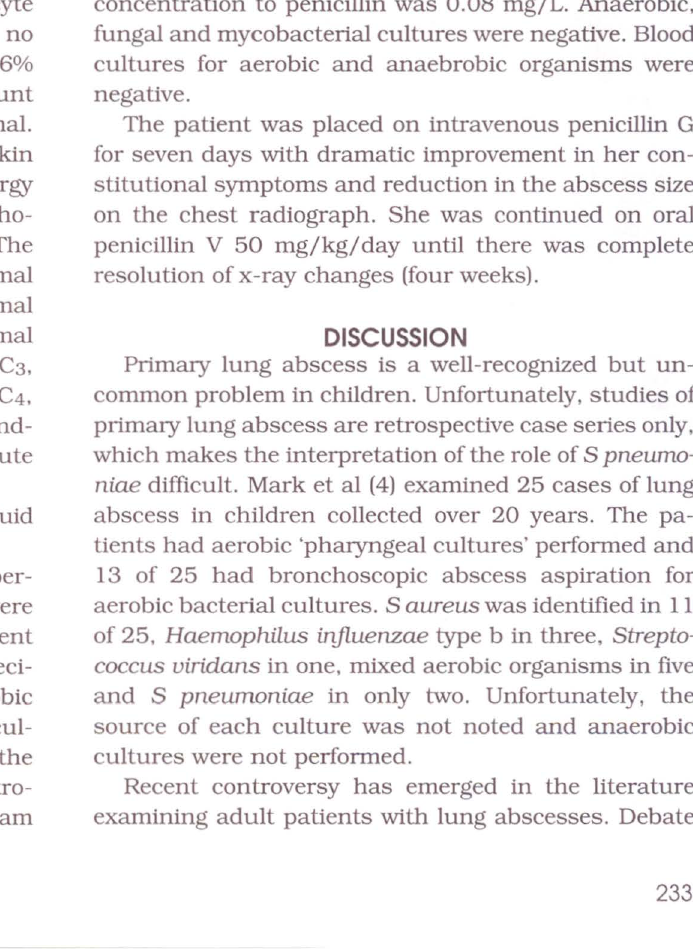
stain and S pneumoniae type 14 was isolated in pure culture. The organism was sensitive to oxacillin, eryth romycin, tetracycline and vancomycin by the Kirby Bauer disc diffusion method. The minimum inhibitory concentration to penicillin was 0.08 mg/L. Anaerobic, fungal and mycobacterial cultures were negative. Blood cultures for aerobic and anaebrobic organisms were